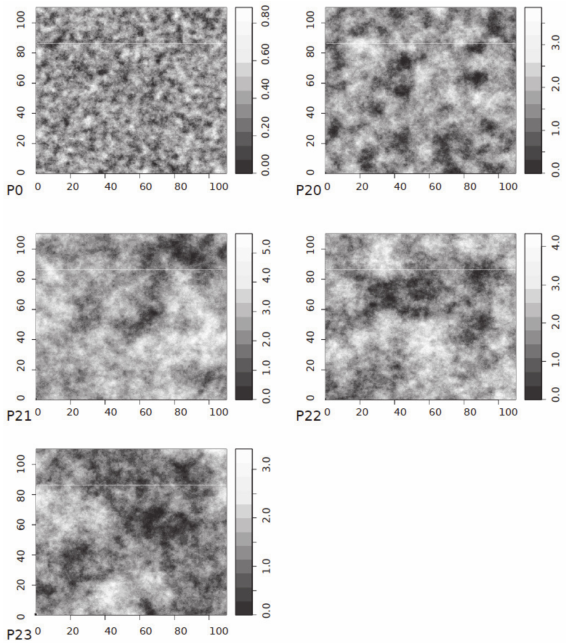
Figure 16. Single random field realisations of the original surfaces P0, P20, P21, P22, P23 (scale values are z coordinates in